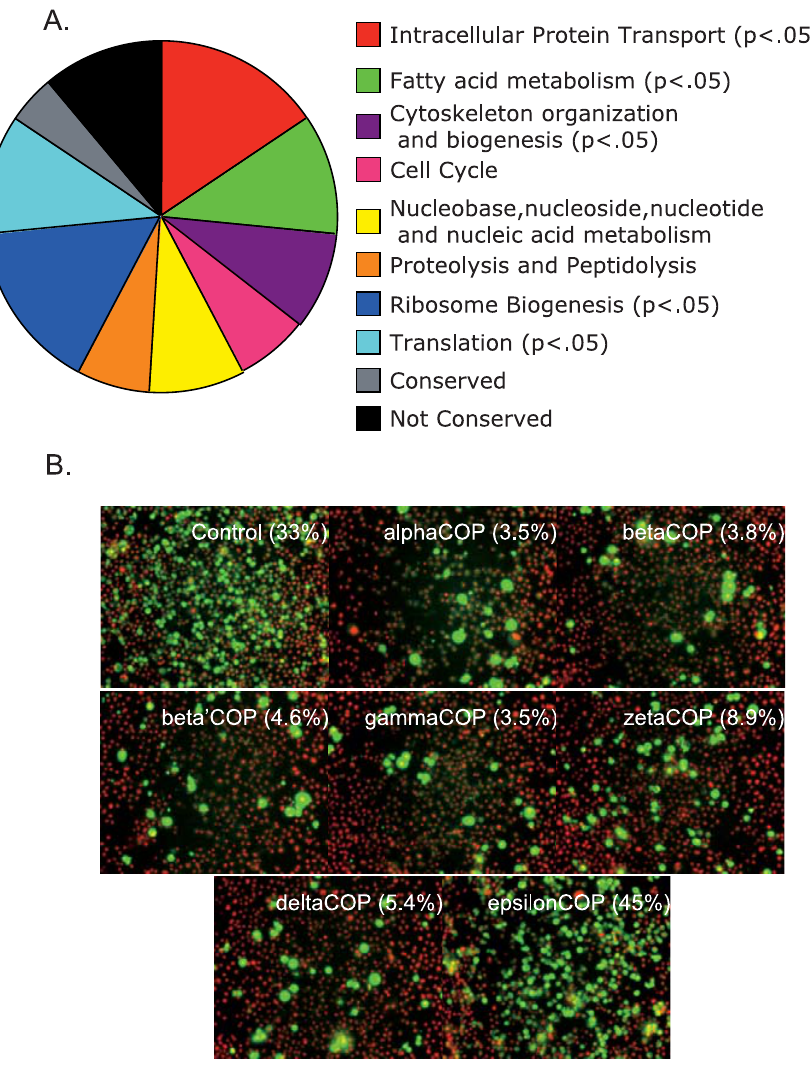
Figure 1. COPI Coatamer Complex Is Required for Viral Replication (A) Frequency of encoded functional groups as curated by GO (The FlyBase Consortium) and manually assigned to representative categories for all verified candidates. Categories that are overrepresented with p , 0.05 are indicated. (B) Decreased viral replication post dsRNA treatment with dsRNA against alphaCOP, betaCOP, beta’COP, gammaCOP, deltaCOP, and zetaCOP as compared to dsRNA treatment with GFP or epsilonCOP . Images were quantified as the percentage of infected cells (FITC-anti DCV [green]) divided by (Hoescht 33342 [red]). DOI: